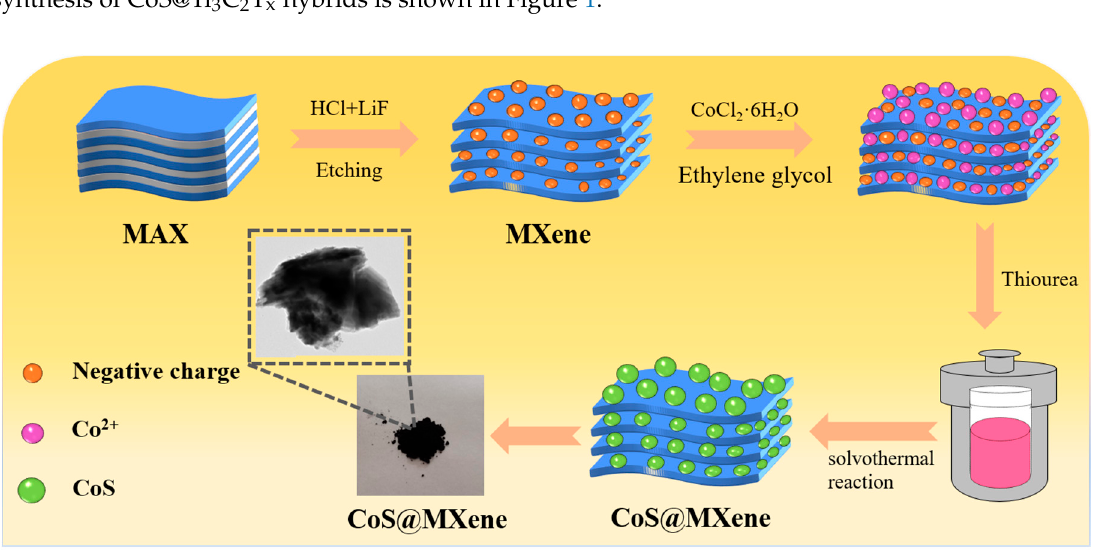
Figure 1. Schematic diagram of the synthesis of CoS@Ti 3 C 2 T x composites.